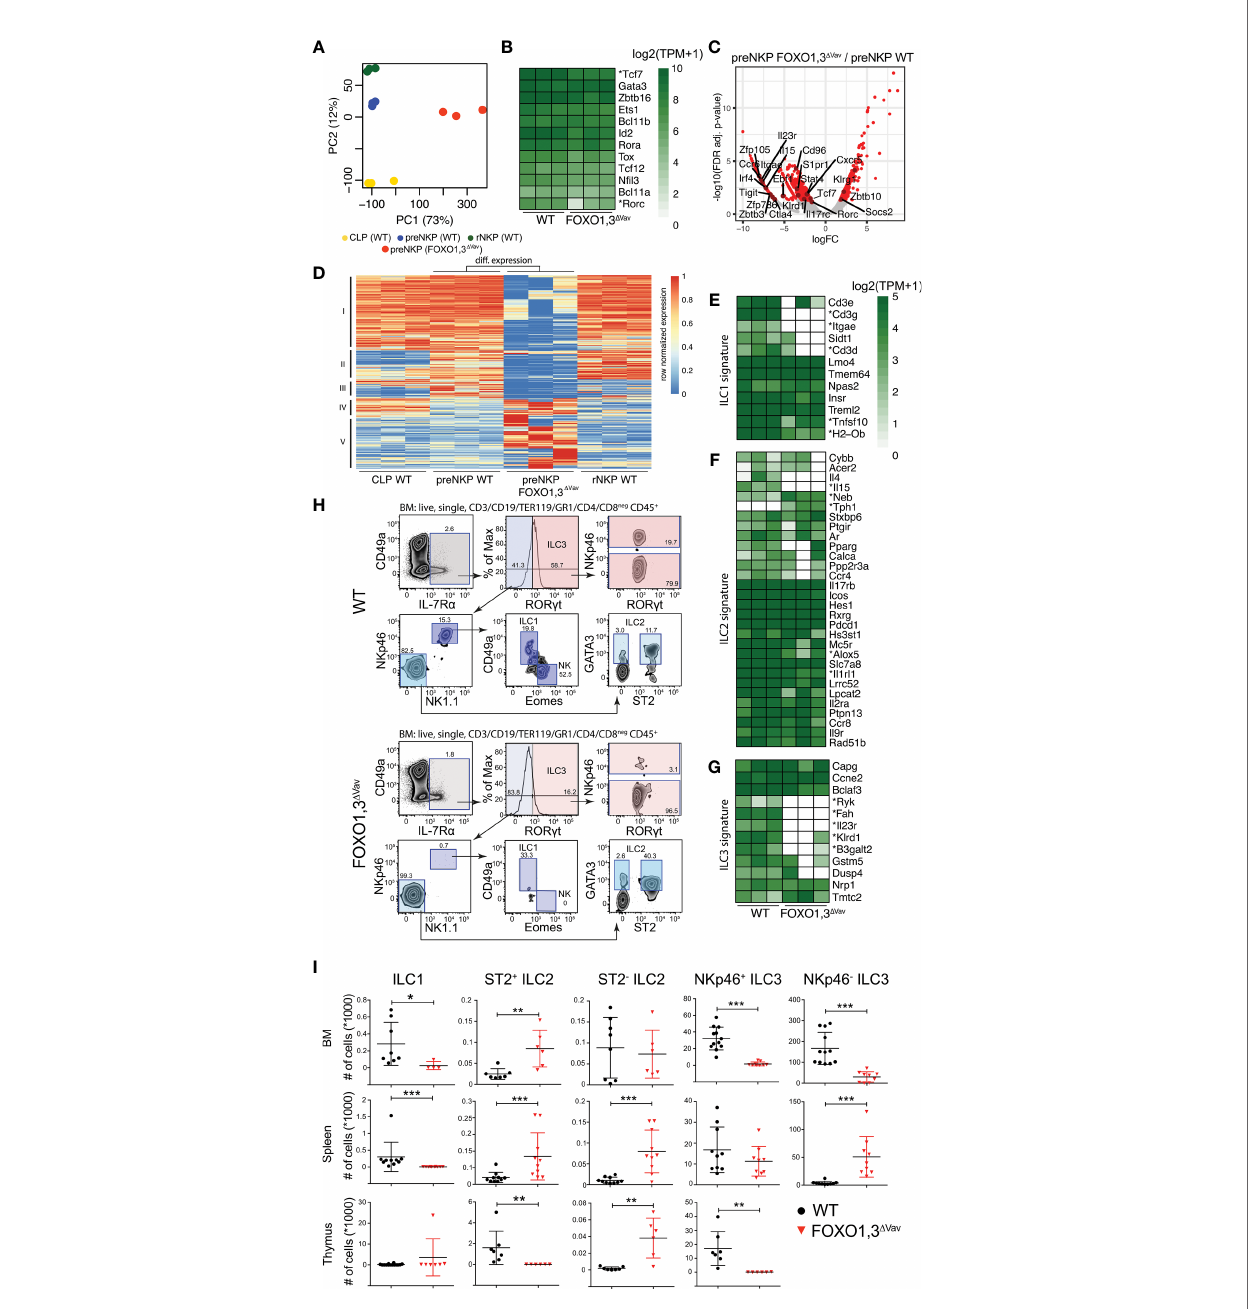
FIGURE 6 | Loss of FOXO results in a perturbation of the preNKP transcriptional program and the development of non-cytotoxic ILCs. (A) Principal component (PC) analysis of RNAseq data from indicated cell populations (for gating strategy see Figure 1A ) from wildtype and FOXO1,3 D Vav mice (n = 3). The variation explained by each PC is displayed in parenthesis. (B) Hierarchically clustered heatmaps showing gene expression for selected transcription factors critical for NK/ILC development. * indicates signi fi cant differences in expression between WT and FOXO1,3 D Vav preNKPs (FDR < 0.05, >2-fold change). (C) Volcano plot showing log2 fold change and adjusted p-value for the comparison of WT to FOXO1,3 D Vav preNKPs. Red dots indicate genes with >2-fold change in expression and adjusted p-value < 0.05. (D) Hierarchically clustered heatmap showing row normalized expression of differential expressed genes (identi fi ed in C). Clusters I-V are indicated. (E – G) Hierarchically clustered heatmaps showing gene expression of (E) ILC1, (F) ILC2 and (G) ILC3 signature genes de fi ned by Robinette et al. (64), * indicates signi fi cant differences in expression between WT and FOXO1,3 D Vav preNKP (FDR < 0.05, >2-fold change). (H) Representative fl ow cytometry pro fi les showing the identi fi cation of ILC subsets in BM from WT and FOXO1,3 D Vav mice. (I) Total number of indicated ILC subsets in BM, spleen and thymus from WT and FOXO1,3 D Vav mice (n = 6-12). NKp46- ILC3 population had less than 50 cells per thymus in all mice from both mouse strains so was not shown. Dots represent individual analyzed animals. Bars indicate mean and SD. P-values were calculated using Mann-Whitney tests with *, ** and *** indicates p-values <0.05, <0.01 and <0.001